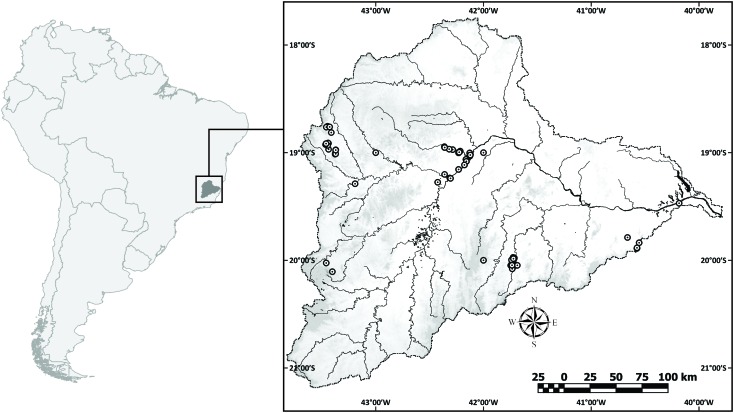
Map of Doce River Basin, including sample sites distribution.